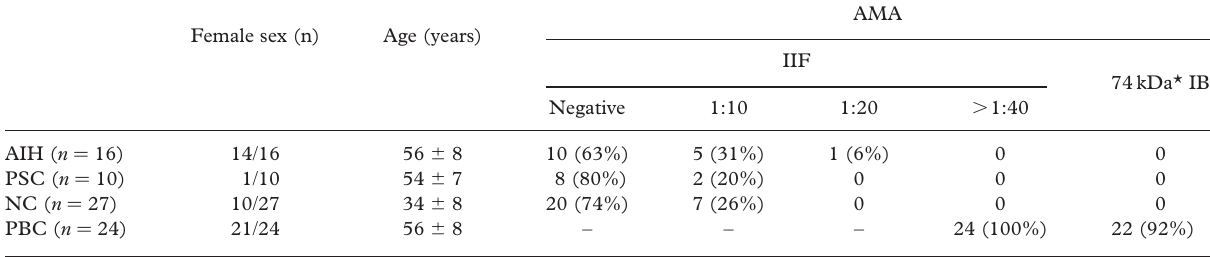
Table I. AMA patterns of studied PBC and non-PBC sera analyzed by indirect IIF and IB with BHM. Anti-PDC-E2 positivity at IB was determined as the reactivity against the characteristic 74kDa protein. Continuous variables are expressed as mean ^ standard error.